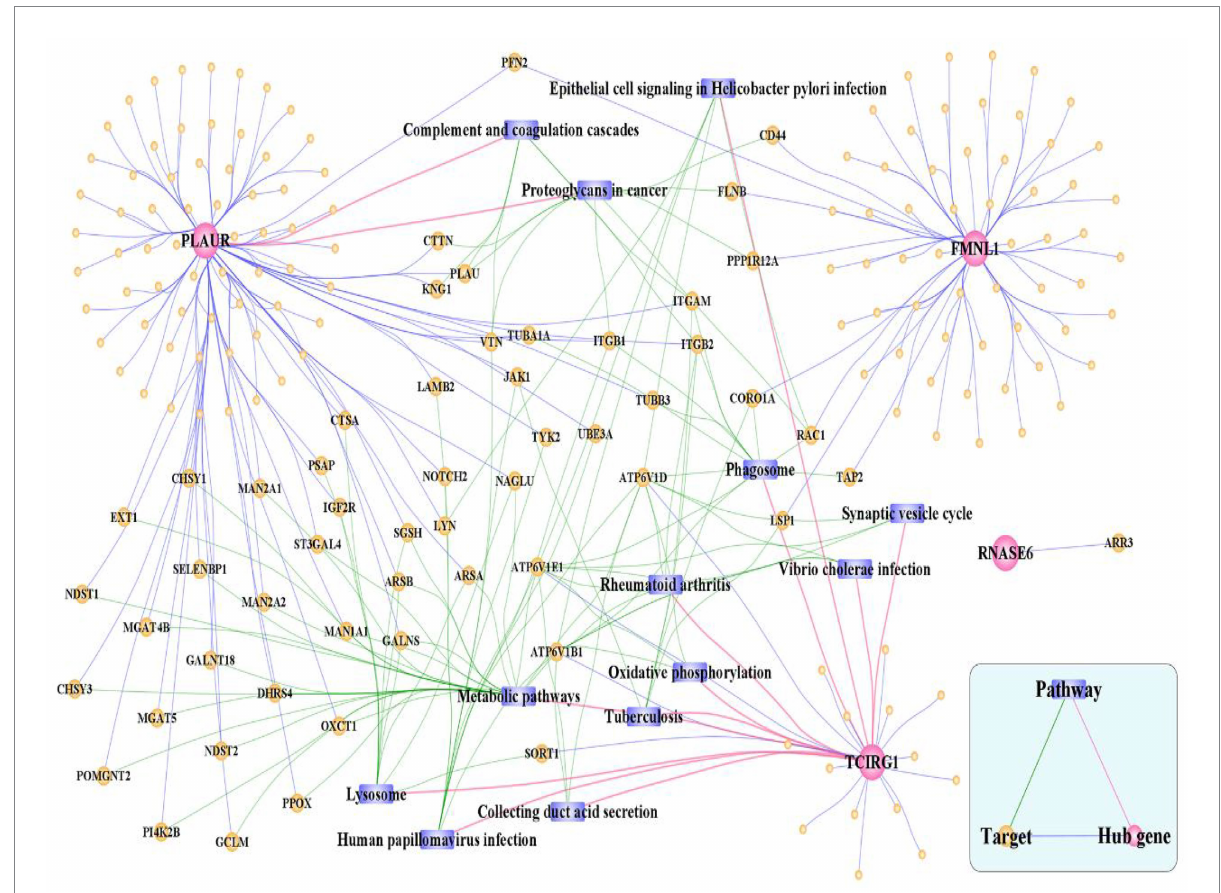
FIGURE 14 Hub cross-talk gene related complex network. The network consists of 210 nodes and 303